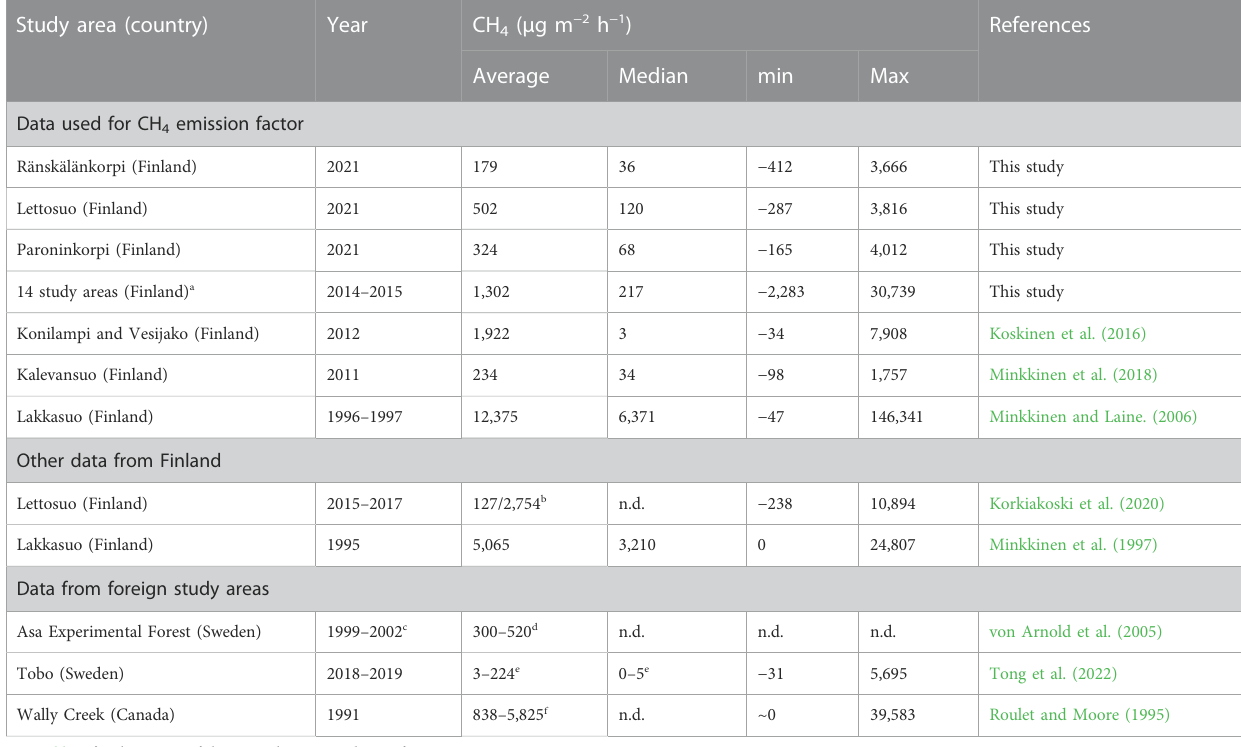
TABLE 2 Average, median and range of CH 4 emission/sink measurements from ditches of boreal forestry-drained peatlands in Finland and in other countries. Study area